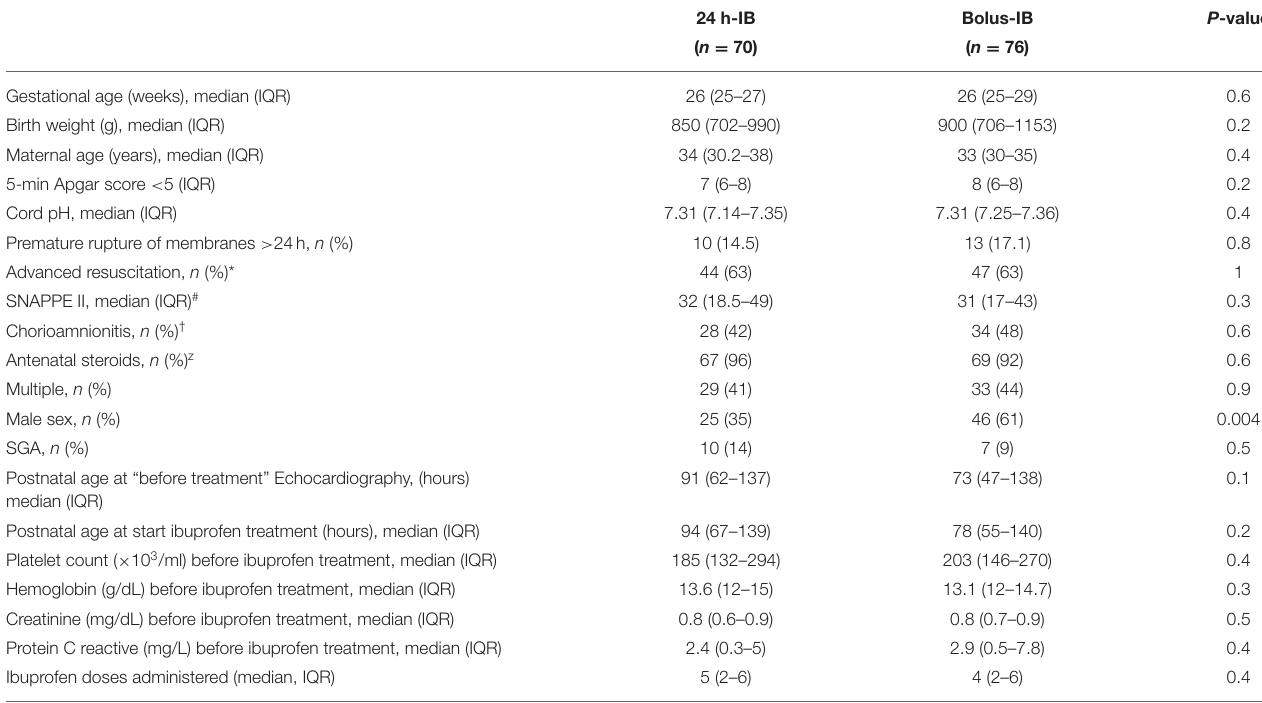
TABLE 1 | Clinical data of the study